Question: What style of plot is this figure drawn as?
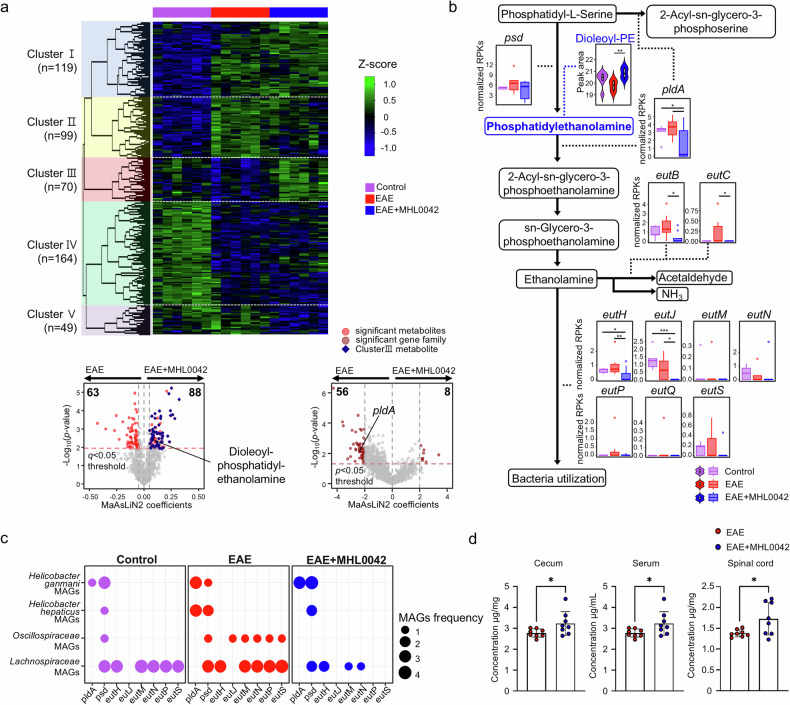
Answer: heatmap